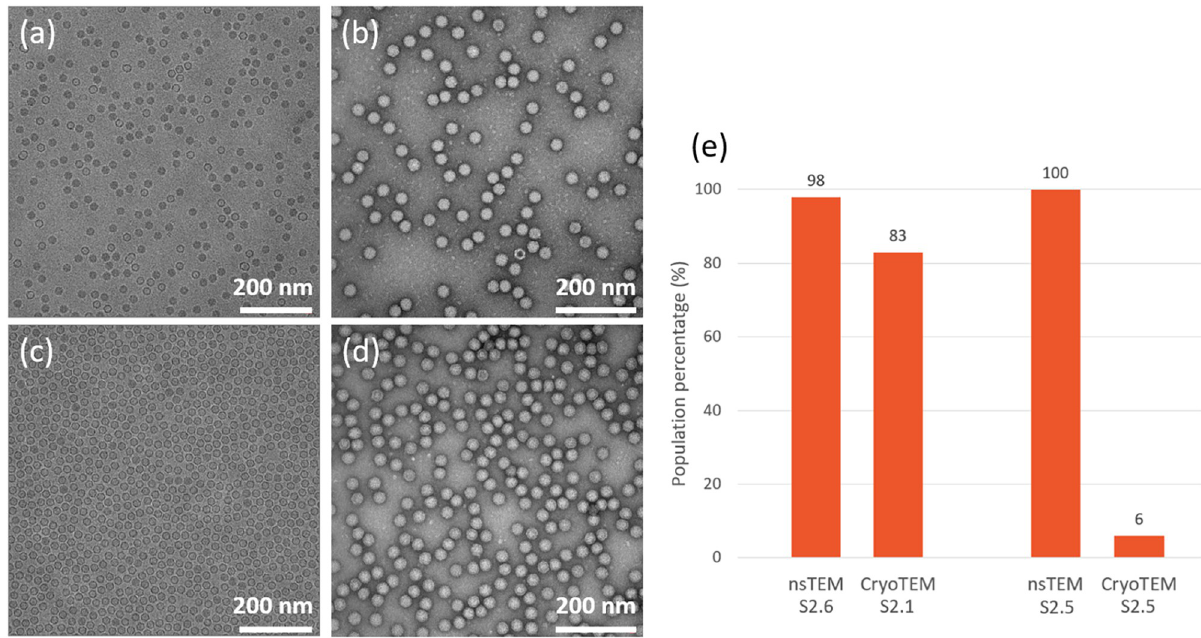
Fig 5. Comparison of specimens in CryoTEM and nsTEM. (a) CryoTEM image of specimen S2.1 , rich in AAV particles carrying a genome. (b) nsTEM image of specimen S2.6 . (c) CryoTEM image of specimen S2.5 , rich in empty particles. (d) nsTEM image of specimen S2.5 . Scale bar represents 200 nm. (e) Comparison on the assessment of the percentage of full particles between nsTEM and CryoTEM. The population of full particles in specimen S.2.5 , rich in empty particles, is overrepresented in nsTEM. Scale bar represents 200 nm.